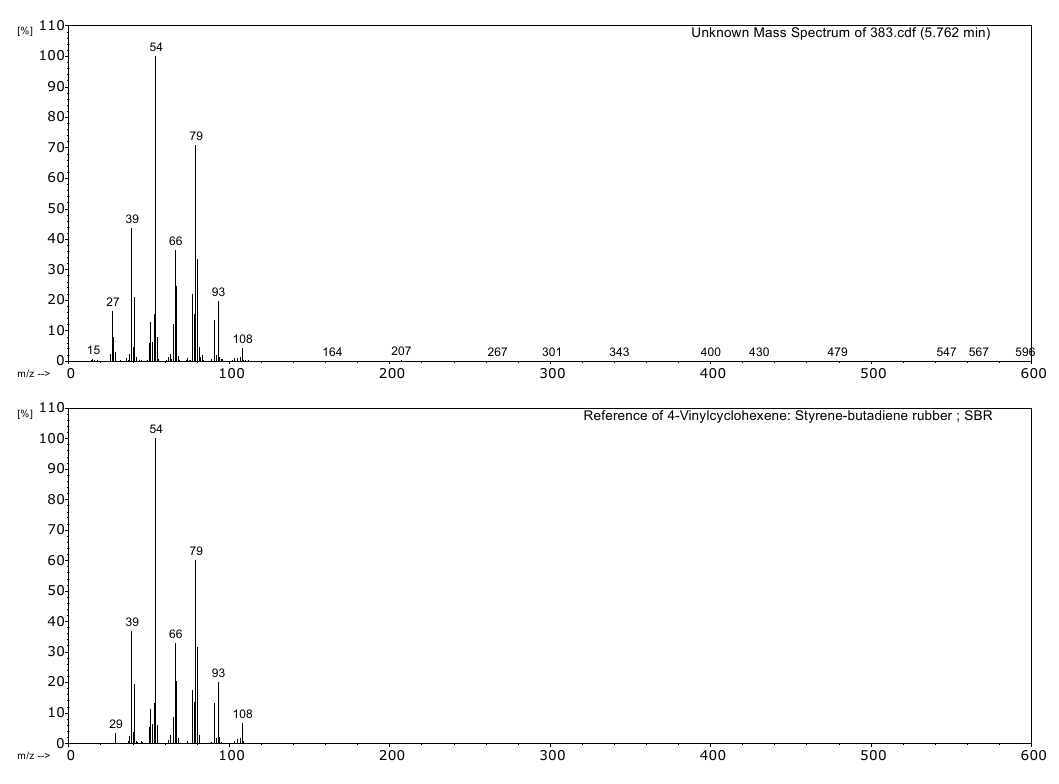
Figure 11. Mass spectrum of peak eluting at 5.76 min in the pyrogram of sample 383, along with a reference spectrum (F ‐ Search database).